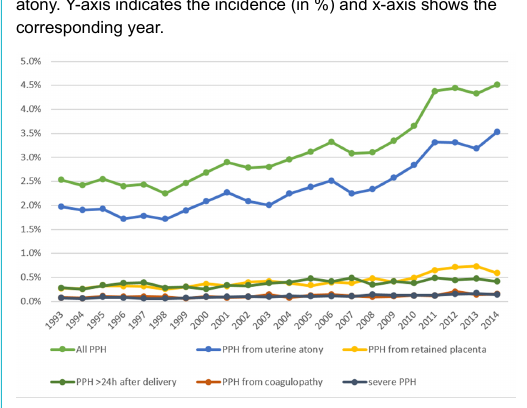
Table 1: Risk factors associated with postpartum haemorrhage.